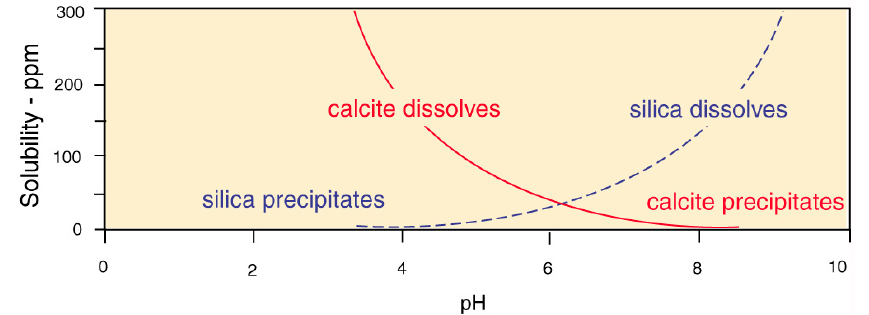
Figure 23. Solubility of calcite and silica at 25 °C. Data adapted from [52,53]. Reprinted from [54].